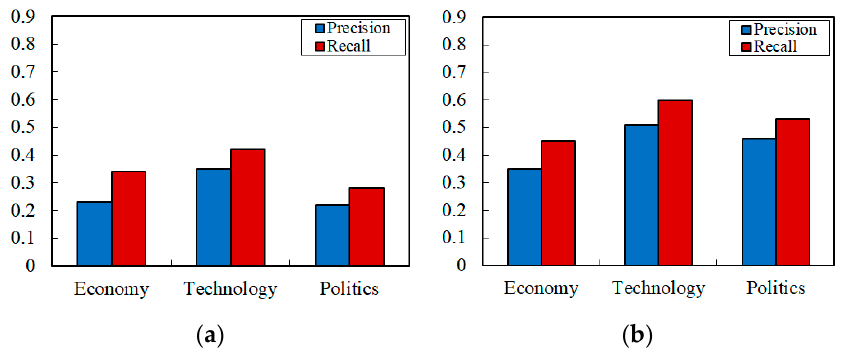
Figure 13. Filtering efficiency based on Wu–Manber multi-pattern matching ( a ) before pattern expansion and ( b ) after pattern expansion.